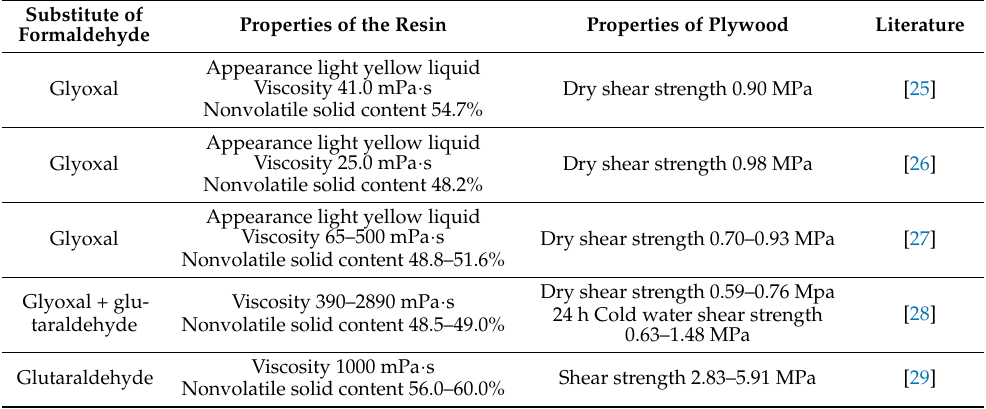
Table 1. Substitutes of formaldehyde and properties of resins and